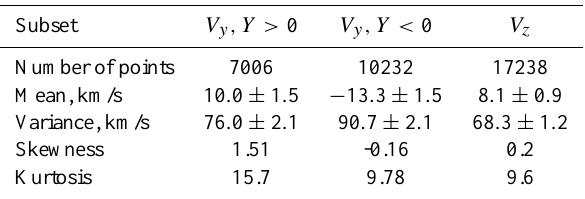
Table 1. Moments of V y , V z PDFs. Skewness and kurtosis are normalized by the variance. 90%-confidence intervals are included for mean and variance